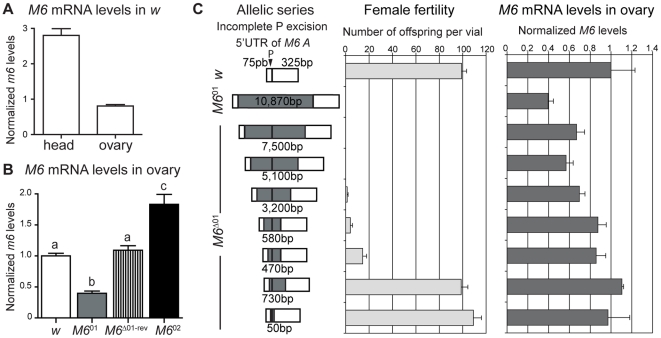
A subtle reduction in M6 mRNA levels is enough to trigger female sterility.(A) M6 mRNA levels were measured in ovaries and heads from control flies by RT-qPCR. Mean ± s.e.m., n = 3; unpaired t-test with Welch correction, p<0.01. (B) M6 mRNA levels in ovaries of control, M6
01 and M6
02 mutants assessed by RT-qPCR. Excision of the original M6
01 insertion restored M6 mRNA levels (M6
Δ01-rev). Mean ± s.e.m., n = 3; logarithmic transformation of the data followed by ANOVA, p<0.001. Different letters indicate significant differences (p<0.001). (C) Correlation between the degree of female sterility and the remaining M6 mRNA levels in ovaries of the allelic series. Left panel: Imprecise P-element excision generated an allelic series (M6
Δ01) spanning seven novel M6 alleles. White boxes represent the 5′ UTR of M6-A; the original P-element insertion in M6
01 (75 bp of the 5′UTR initiation site; black arrowhead) and the remaining transposon sequences in the excised alleles are shown in grey. Residual P-element were mapped by genomic PCR and DNA sequencing (see Table S1). The size of the remaining fragment is indicated. Middle panel: Female fertility was measured as in Figure 1; mean ± s.e.m., n = 3. Right panel: M6 mRNA levels in ovaries was measured by RT-qPCR and normalized; mean ± s.e.m., n = 3. Note that two alleles restored M6 mRNA to wild type levels and fully rescued the female phenotype. Spearman correlation coefficient between female fertility and M6 mRNA levels is rs = 0.92.